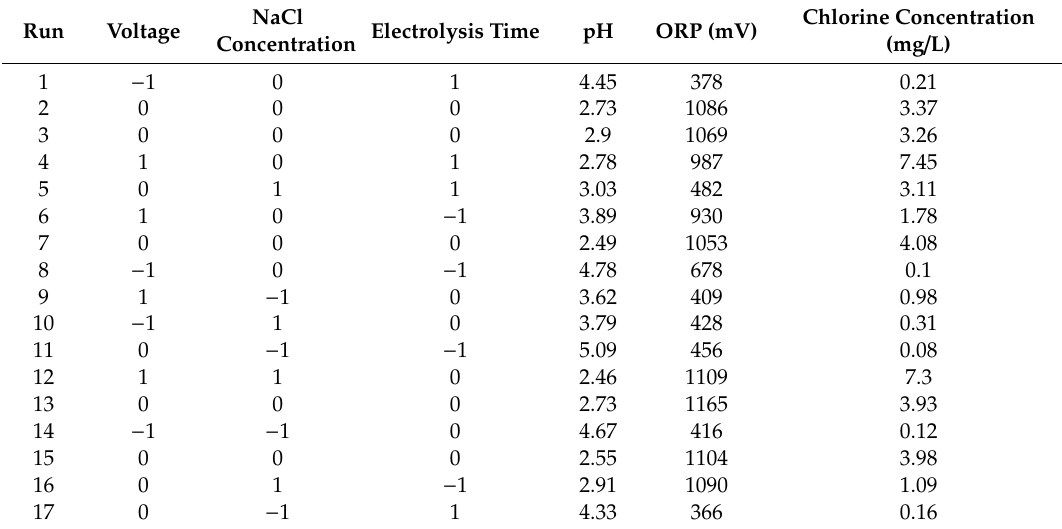
Table 6. Box–Behnken response surface design arrangement and response for acidic electrolyzed water (AcEW).